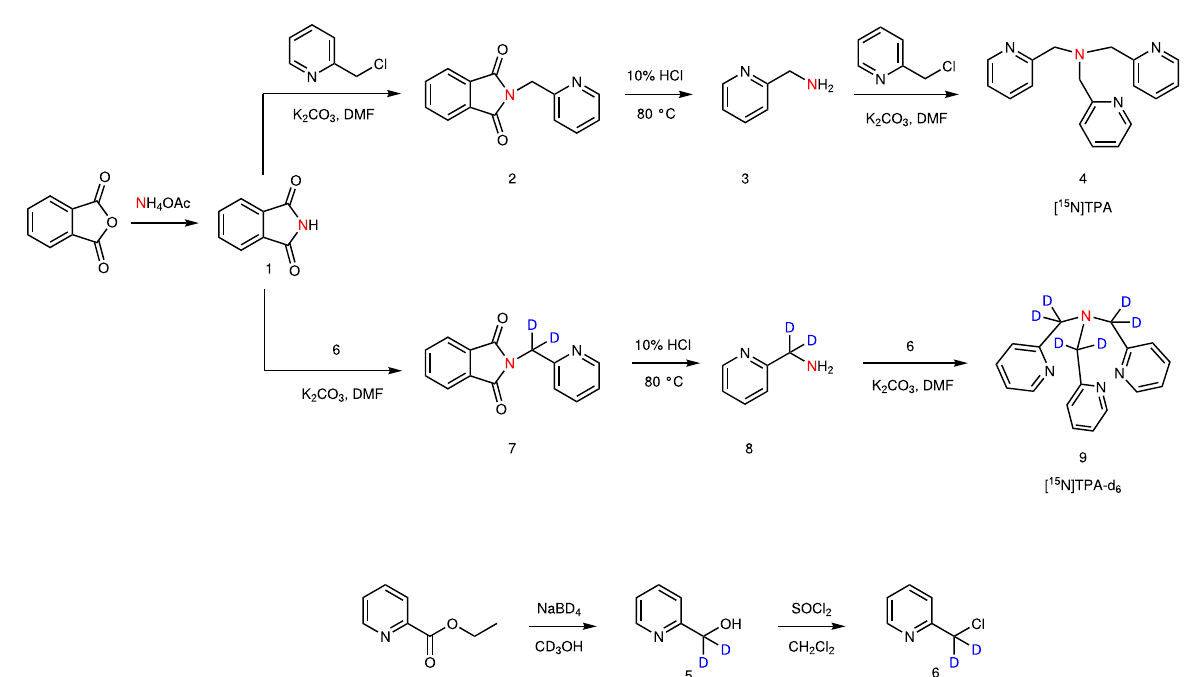
Fig. 2 Synthesis of 15 N-labeled TPA derivatives. The key intermediate in the synthesis is [ 15 N]phthalimde ( 1 ), conveniently prepared by heating a mixture of phthalic anhydride and [ 15 N]ammonium